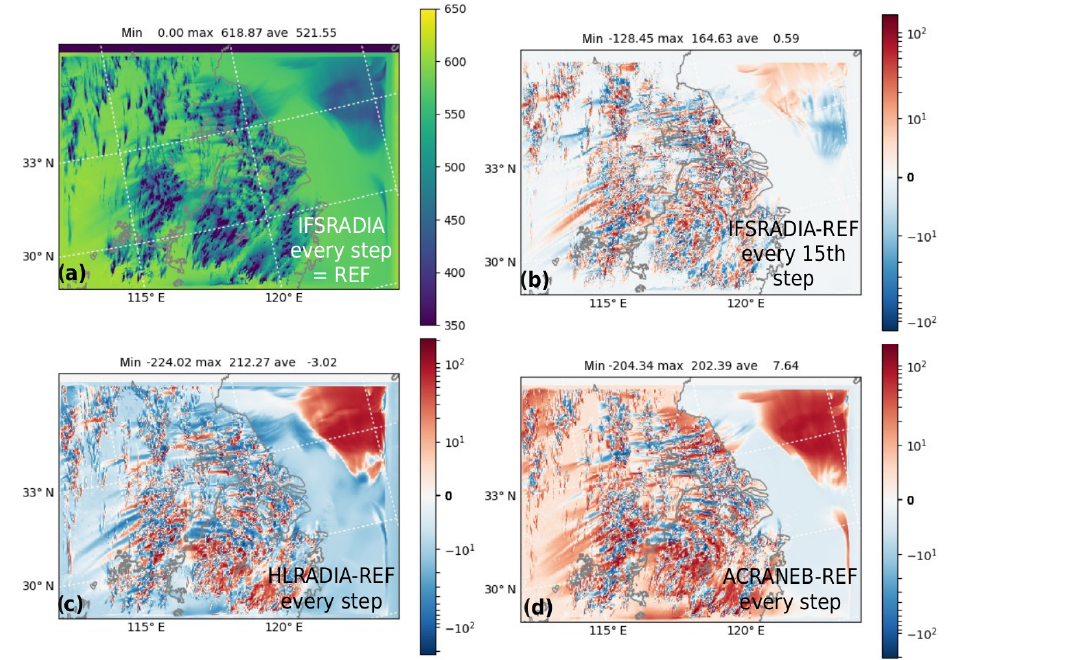
Figure 9. Average downwelling global radiation (SWDS, Wm − 2 ) over the Shanghai area according to the HARMONIE-AROME 00:00UTC + 12h forecast for the 7 July 2010: (a) reference IFSRADIA (REF) called at every time step, (b) difference of IFSRADIA (IFS) called at every 15th time step from REF, IFS – REF, (c) HLRADIA called at every time step – REF, (d) ACRANEB called a every time step –